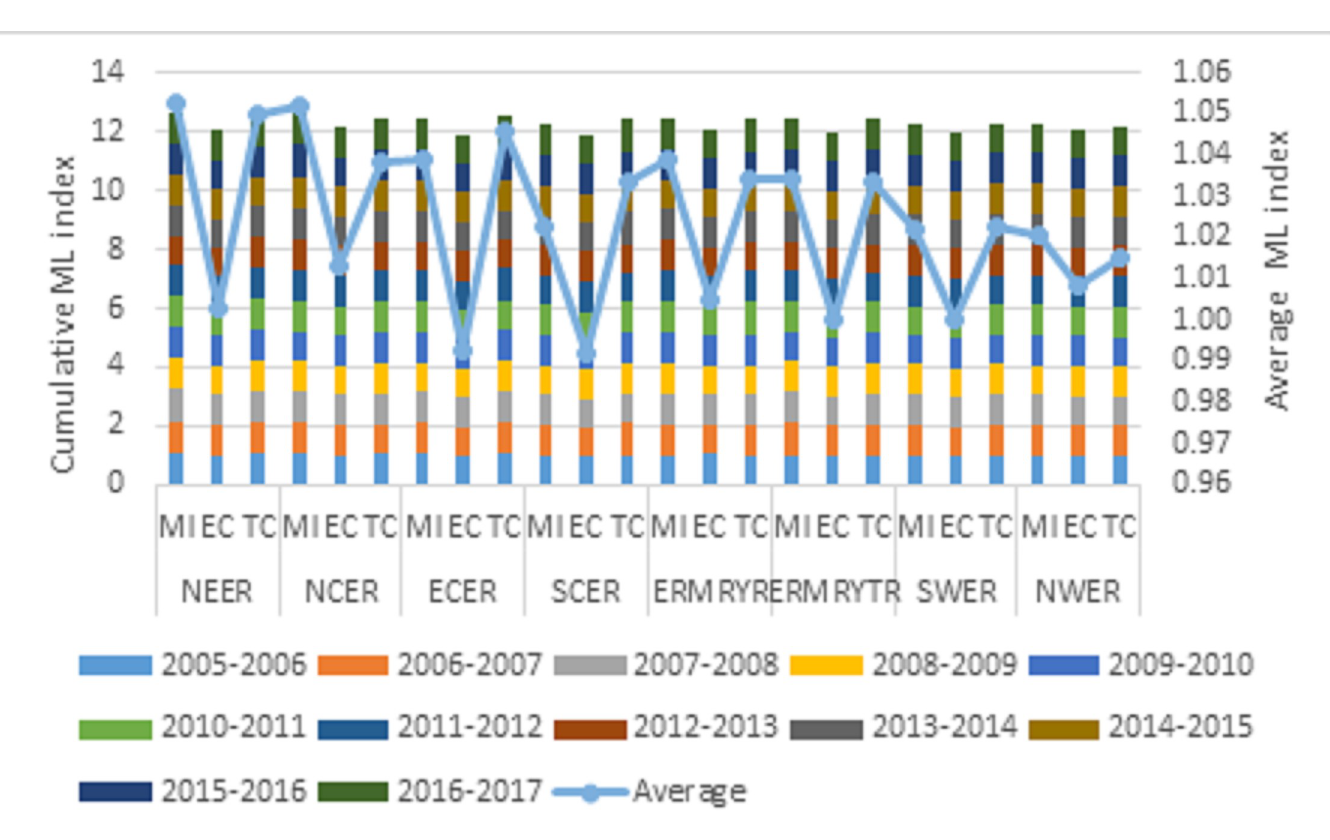
Fig 4. The ML index and its decomposition